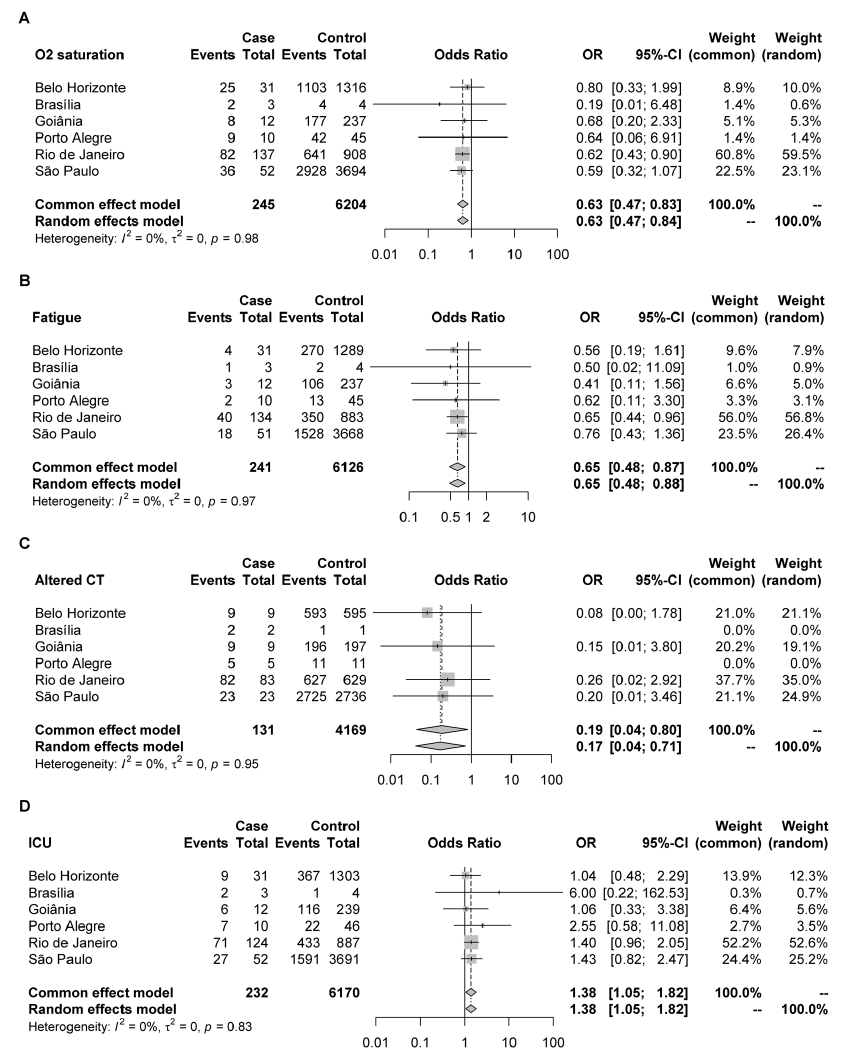
Figure 5. Symptoms/clinical tests occurrence in Delta (case) and Gamma (control) groups in Coronavirus disease 2019 (COVID-19) patients from six different capitals of Brazil. The Forest plot describes the observations for: ( A ) O 2 saturation; ( B ) fatigue; ( C ) altered chest computed tomography; ( D ) intensive care unit (ICU) admission.